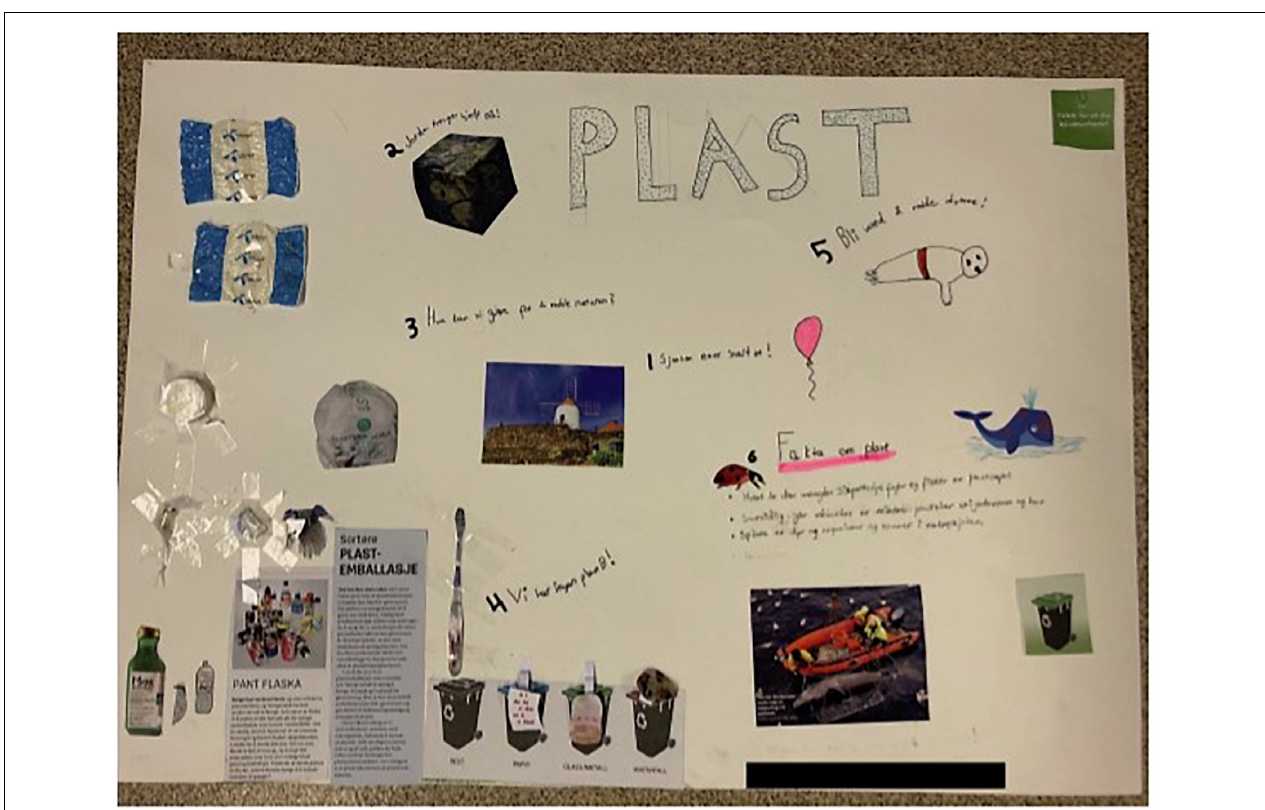
FIGURE 3 | Example for outcome of creative engagement featuring negative consequences for animals.